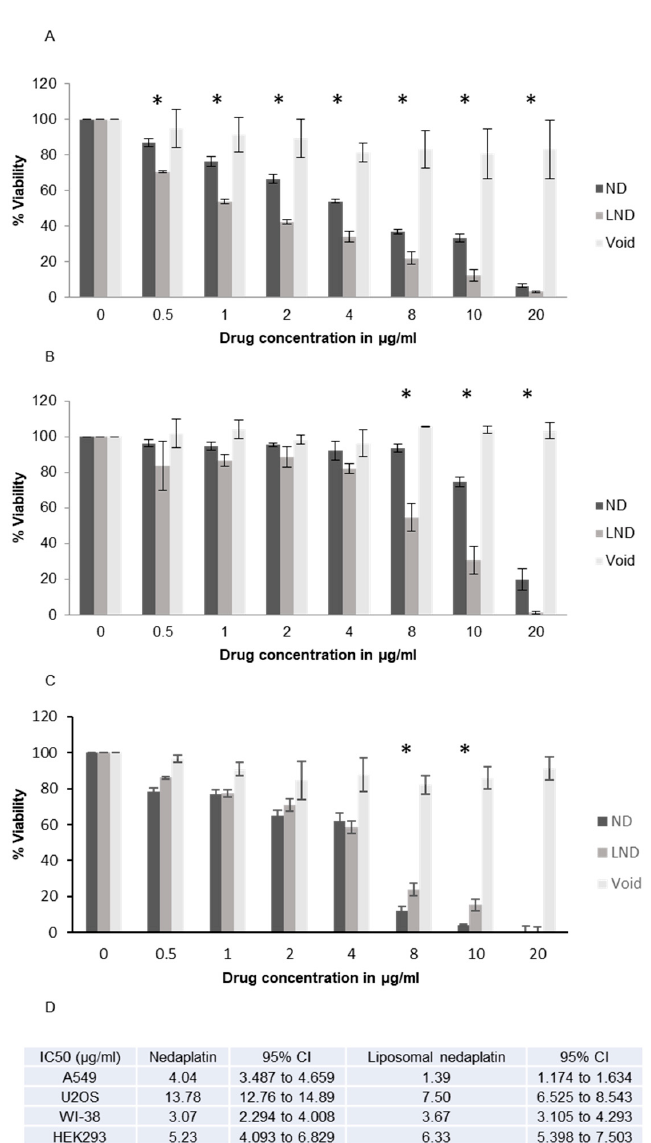
Figure 3. Evaluating cytotoxicity of free and liposomal nedaplatin after 72 h of drug exposure using MTT assay in ( A ) A549, ( B ) U2OS, and ( C ) WI-38. ( D ) IC50 table. An overall statistically significant di ff erence in cell viability was observed between LND and ND in A549 and U2OS ( p -value < 0.05) with LND being more cytotoxic. This was not observed in WI-38. Multiple pair-wise t -tests show the concentrations at which a significant difference between both drugs was observed. These points are indicated by asterisks * ( p < 0.05).